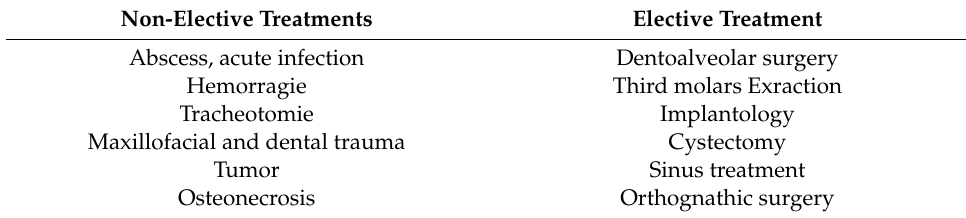
Table 2. Elective and non-elective treatments performed at the Department of Oral and